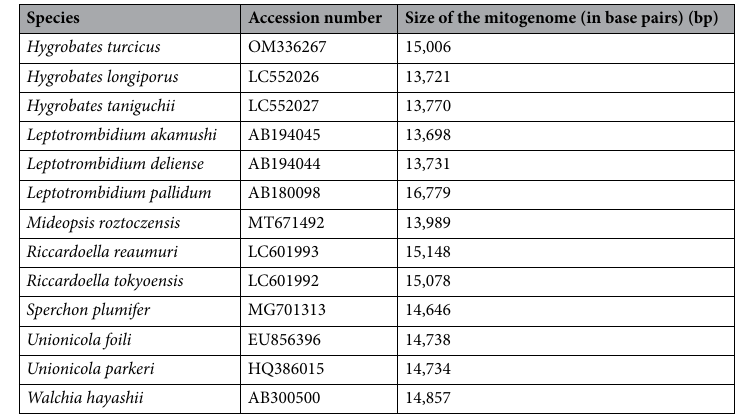
Table 1. List of the mitogenomes used during this study with their accession number and sizes.